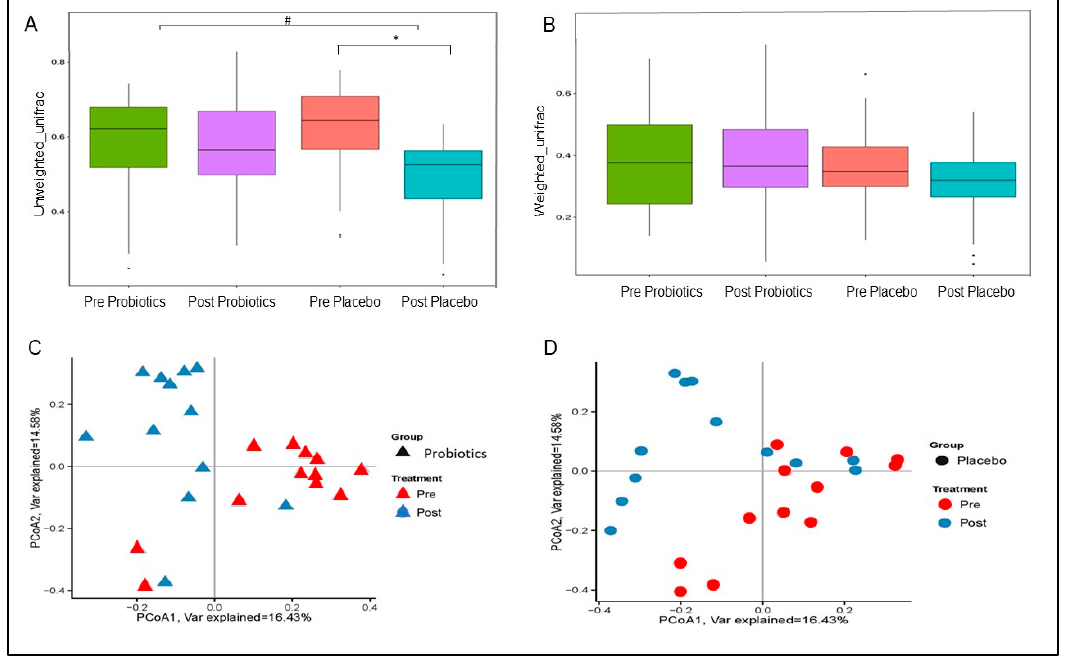
Figure 6. Changes in gut microbial β diversity within the two groups. ( A ) Boxplots of unweighted UniFrac distance. ( B ) Boxplots of weighted UniFrac distance. Principal coordinate analysis (PCoA) plots based on Bray–Curtis (BC) distance within the probiotics ( C ) and placebo ( D ) groups. p -value < 0.05 was considered statistically significant. * Significant difference within the group. # Significant difference between the two groups.